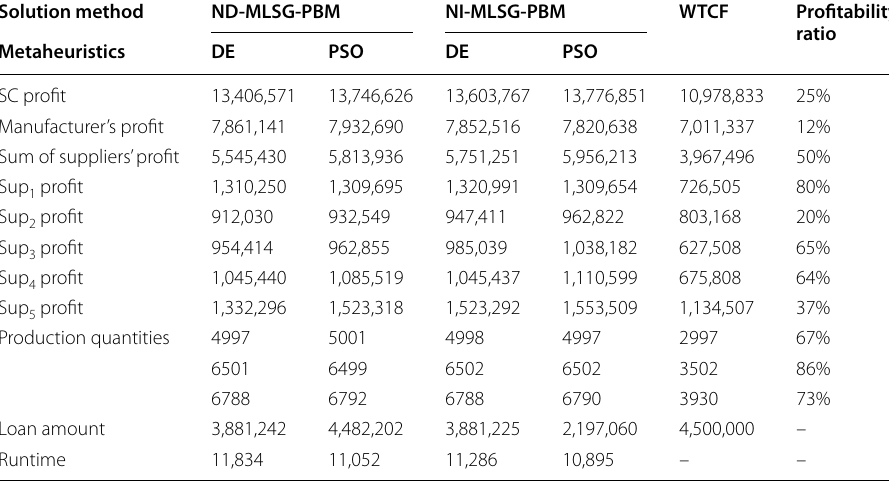
Table 7 A summary of the results for the TCF contract in Sc-2 and WTCF case for the test problems in size 1